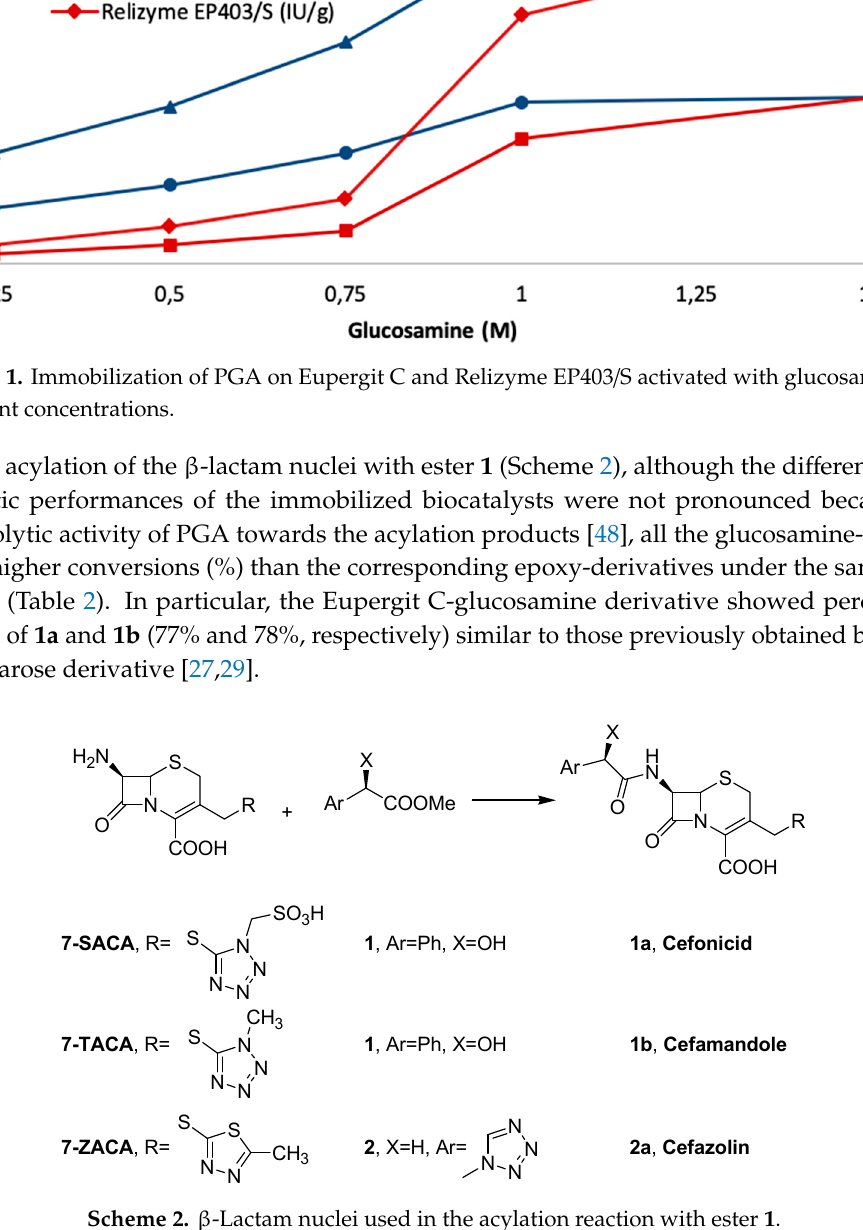
Figure 1. Immobilization of PGA on Eupergit C and Relizyme EP403/S activated with glucosamine at different